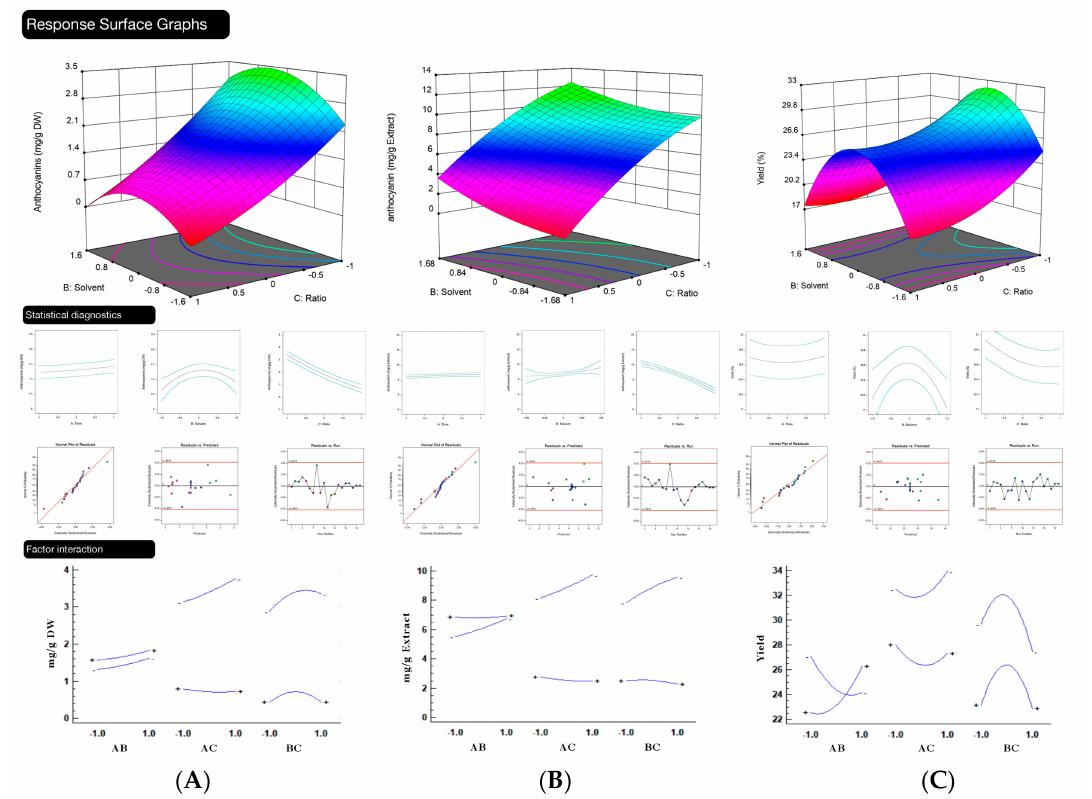
Figure 2. Graphical representation of response surface methodology (RSM) for: ( A ) response Y 1 (anthocyanins mg/g per dry mass). (From left to right and top to bottom: Modeling of the representation of the data obtained with time zero factor; single factorial behavior of time; single factorial behavior of the solvent; single factorial behavior of the ratio; normal residual plot; residuals versus predicted values; predicted values versus execution; and factorial interaction); for ( B ) the Y 2 response (mg/g extract). (From left to right and top to bottom: Modeling data representation obtained with time zero factor; single factorial behavior of time; single factorial behavior of the solvent; single factorial behavior of the ratio; normal residual graph; residuals versus predicted values; predicted values versus execution; and factorial interaction); for ( C ) the Y 3 response (yield). (From left to right and top to bottom: Modeling data representation obtained with time zero factor; single factorial behavior of time; single factorial behavior of the solvent; single factorial behavior of the ratio; normal residual graph; residuals versus predicted values; predicted values versus execution; and factorial